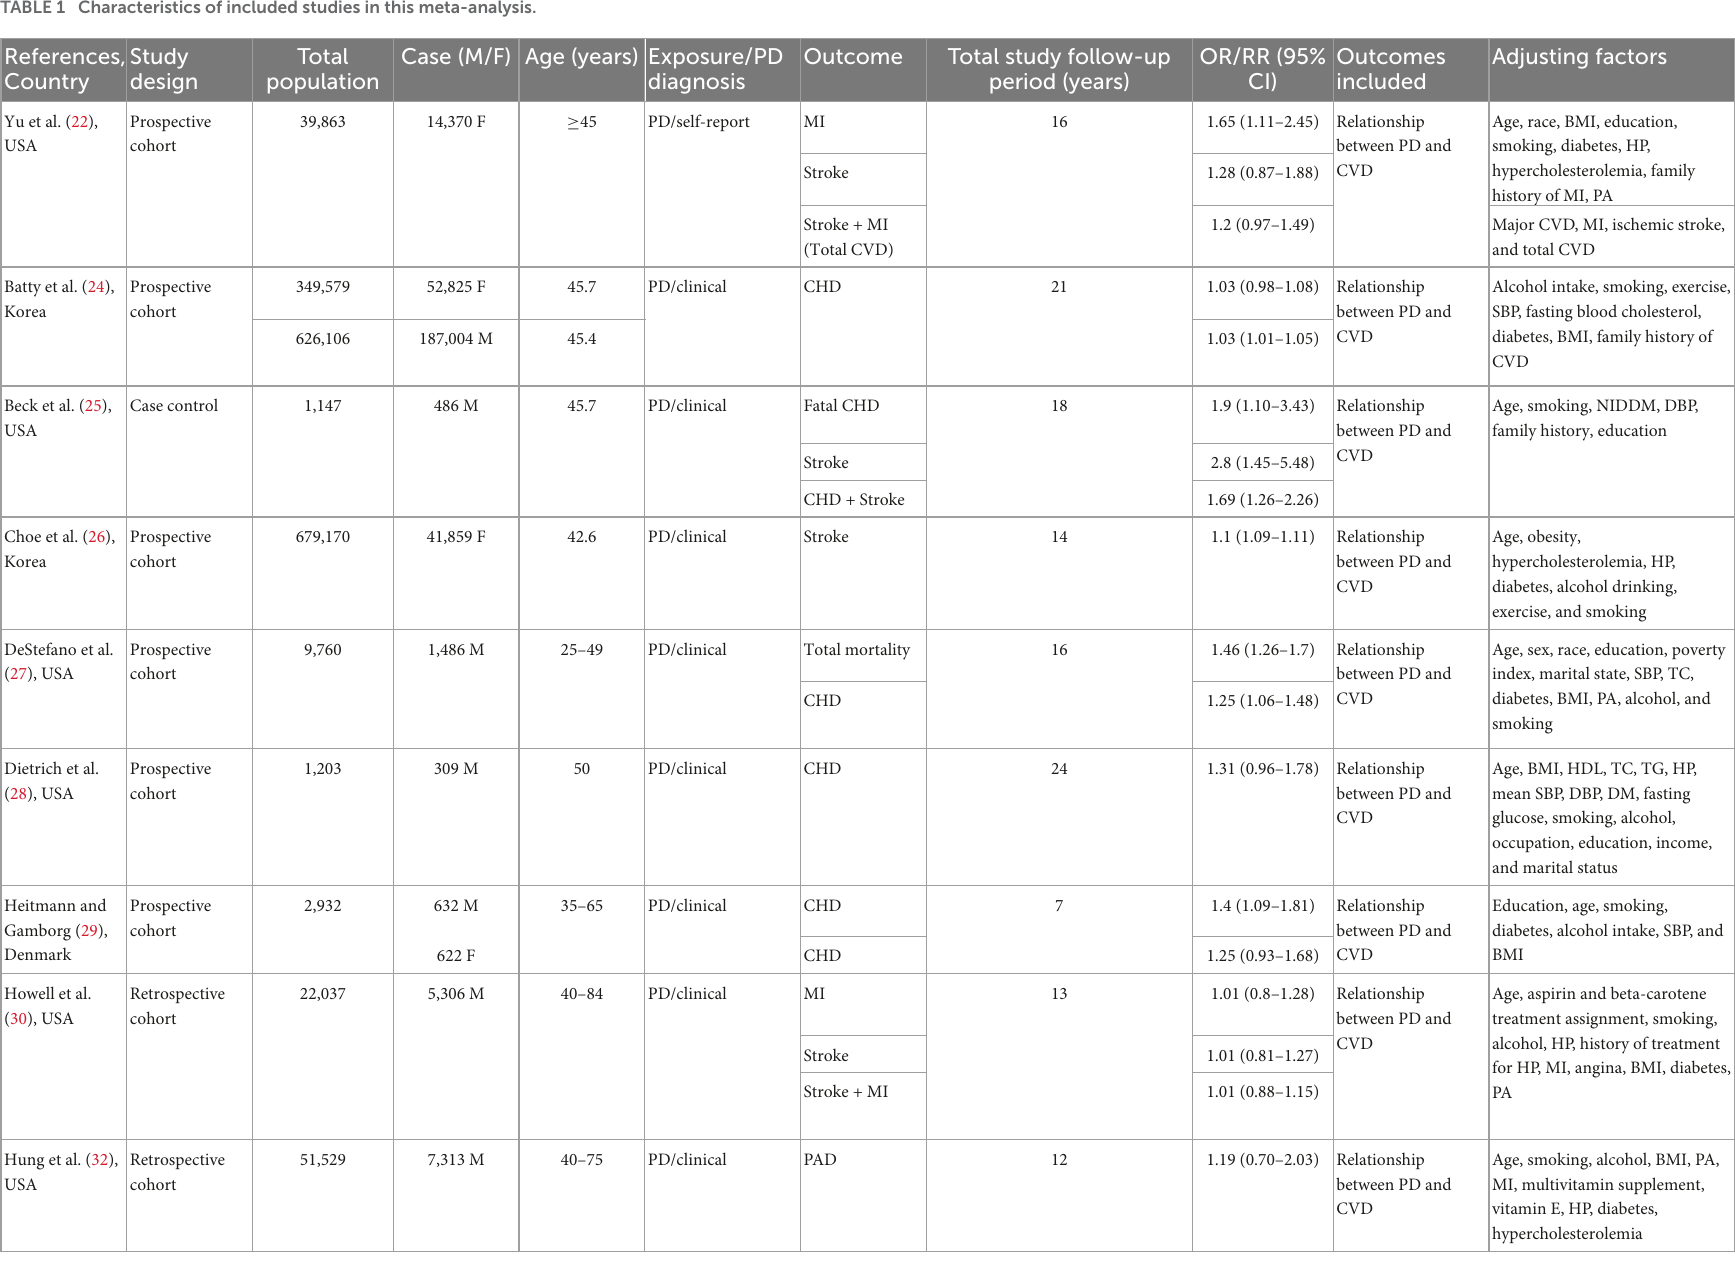
TABLE 1 Characteristics of included studies in this